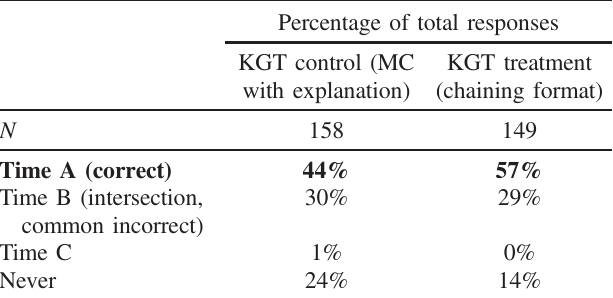
EXPLORING AND SUPPORTING STUDENT (control and treatment) of the kinematics graph task (KGT) administered in experiment 1A. The task itself is shown in Fig. 1(b). There is a small difference in the answer distribution on the chaining format in comparison with the multiple choicewith explanation format ( p ¼ 0 . 025 , V ¼ 0 . 16 ). The correct answer choice is in boldface for reference.